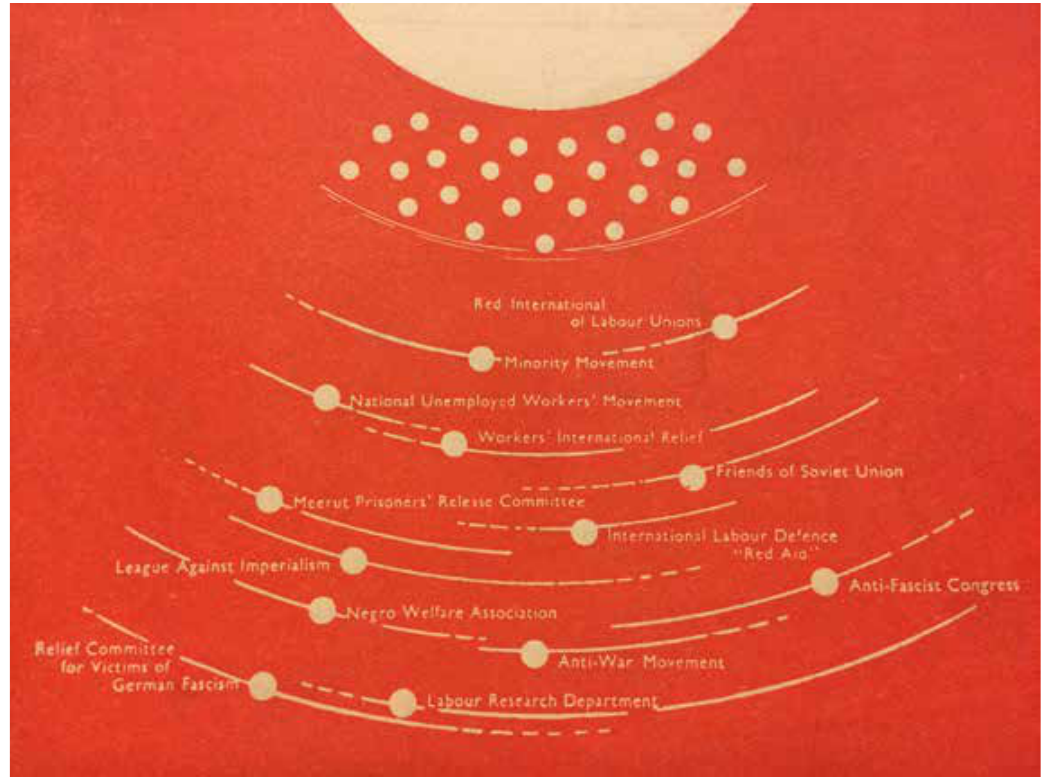
Fig. 2. Detail from the cover of The Communist International , The Communist Solar System (London, 1933). BL,